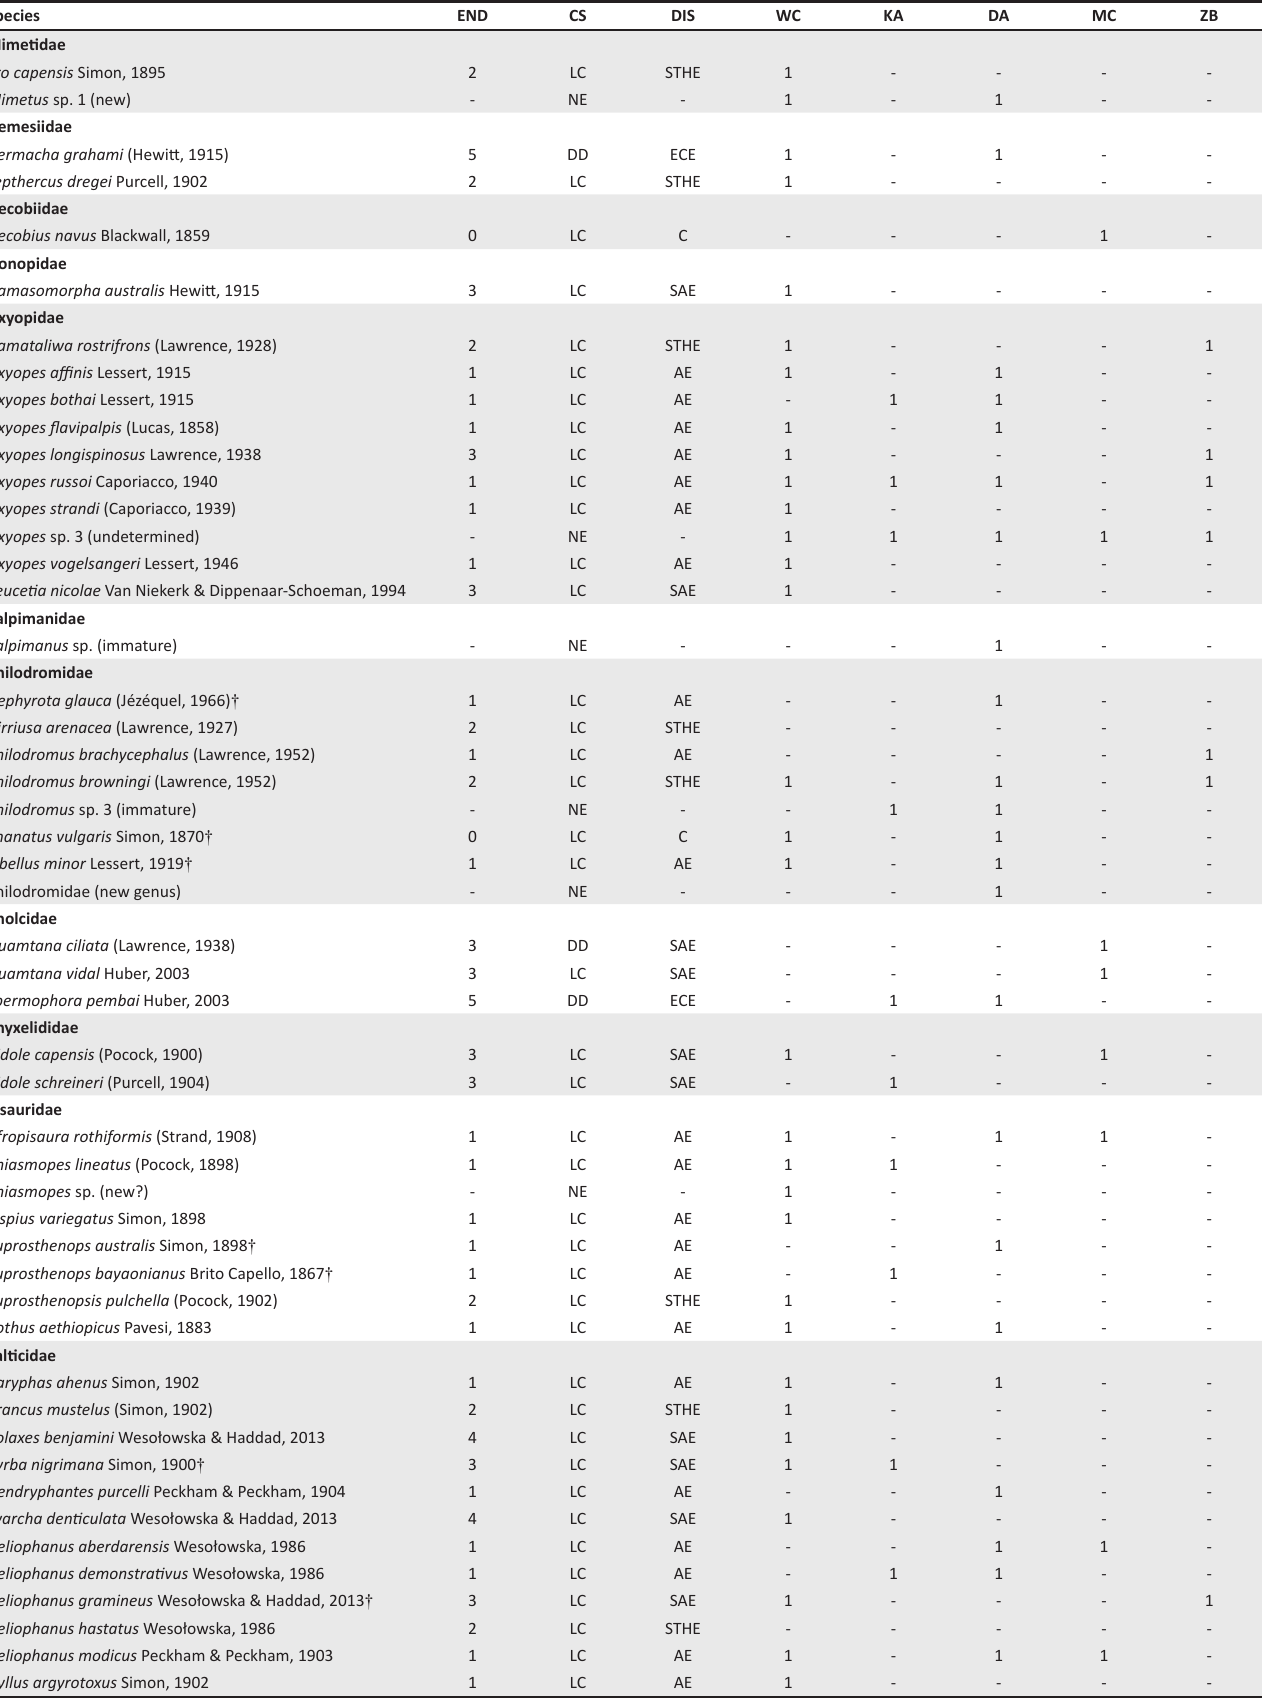
TABLE 1-A1 (Continues): Spiders of the Addo Elephant National Park, listing their endemicity, conservation status, distribution and areas sampled in the park.